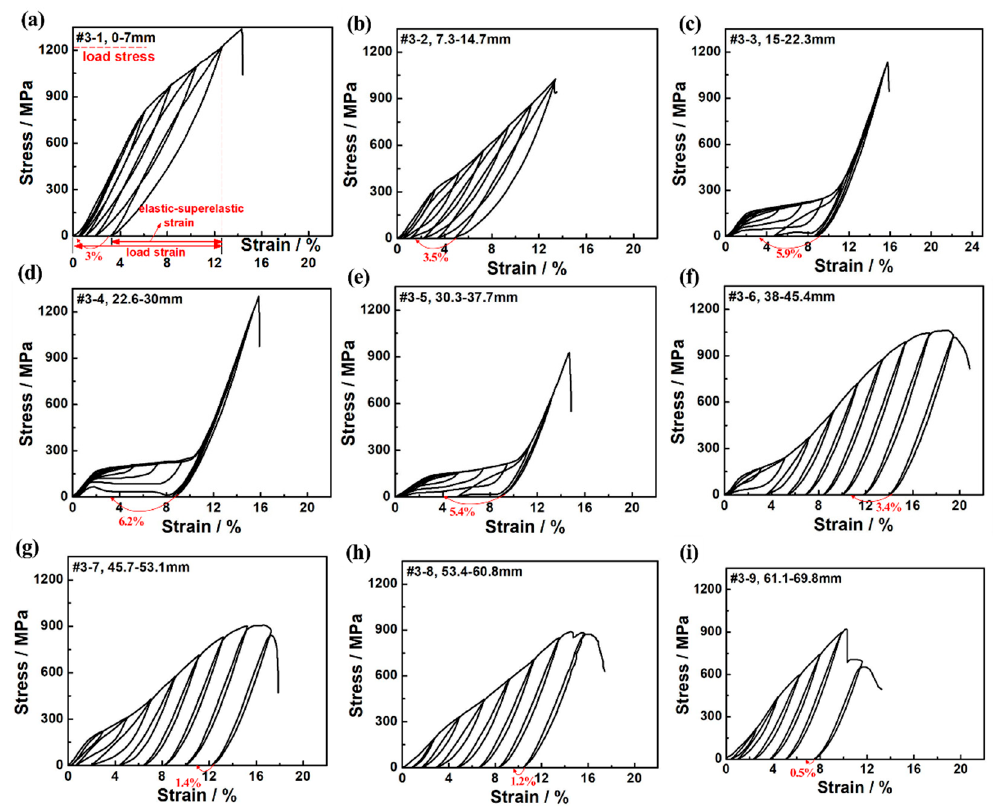
Figure 6. Compressive stress-strain cyclic loading-unloading curves of equal length regions from top to bottom of the #3 sample: ( a ) #3-1, 0~7 mm from the top; ( b ) #3-2, 7.3~14.7 mm from the top; ( c ) #3-3, 15~22.3 mm from the top; ( d ) #3-4, 22.6~30 mm from the top; ( e ) #3-5, 30.3~37.7 mm from the top; ( f ) #3-6, 38~45.4 mm from the top; ( g ) #3-7, 45.7~53.1 mm from the top; ( h ) #3-8, 53.4~60.8 mm from the top; and ( i ) #3-9, 61.1~69.8 mm from the